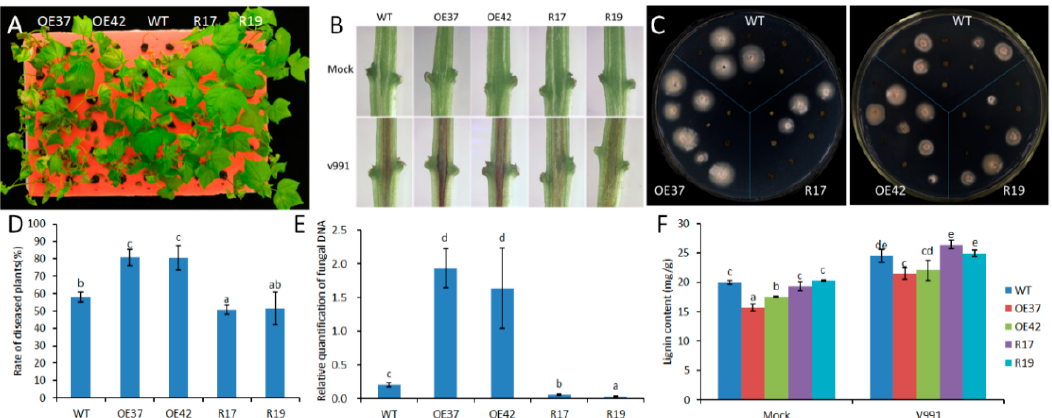
Figure 5. GhHB12 negatively regulates the resistance to V. dahliae in cotton. ( A ) Cotton seedlings (wild-type: WT; overexpression lines: OE37 and OE42; RNAi lines: R17 and R19) 15 days after inoculation with V. dahliae . ( B ) Sections of cotton stems near the cotyledons after V. dahliae inoculation. The brown areas are diseased vascular bundles. ( C ) 15 days after V. dahliae inoculation, stem sections were plated, allowing fungal outgrowth as a measure for fungal colonization. ( D ) Rate of diseased plants 12 days after inoculation with V. dahliae . ( E ) qRT-PCR was used to analyze fungal colonization by comparing the V. dahliae internal transcribed spacer DNA levels (as a measure for fungal biomass) to the cotton GhUBQ7 DNA levels 15 days post-inoculation. ( F ) Lignin content. The data represent the mean ± SE of three independent biological replications, and different letters indicate significant differences at p < 0.05 (Duncan’s multiple range test).